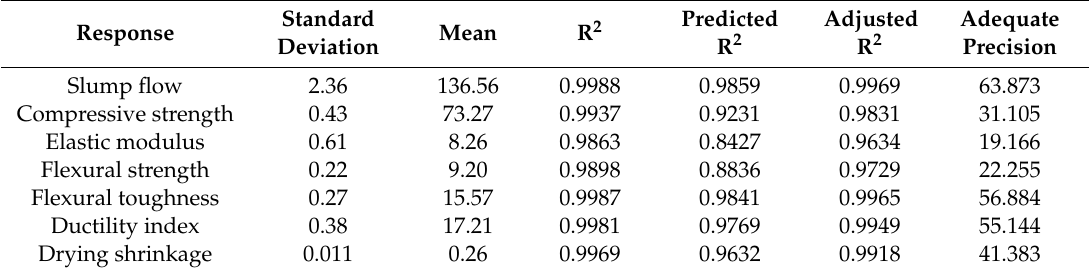
Table 8. Model validation for responses.